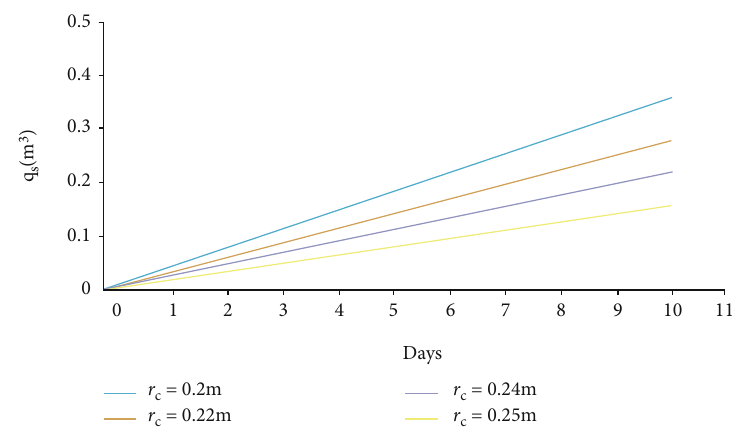
Figure 5: Relationship between the sand production rate and time under di ff erence sand production radii (18 MPa).